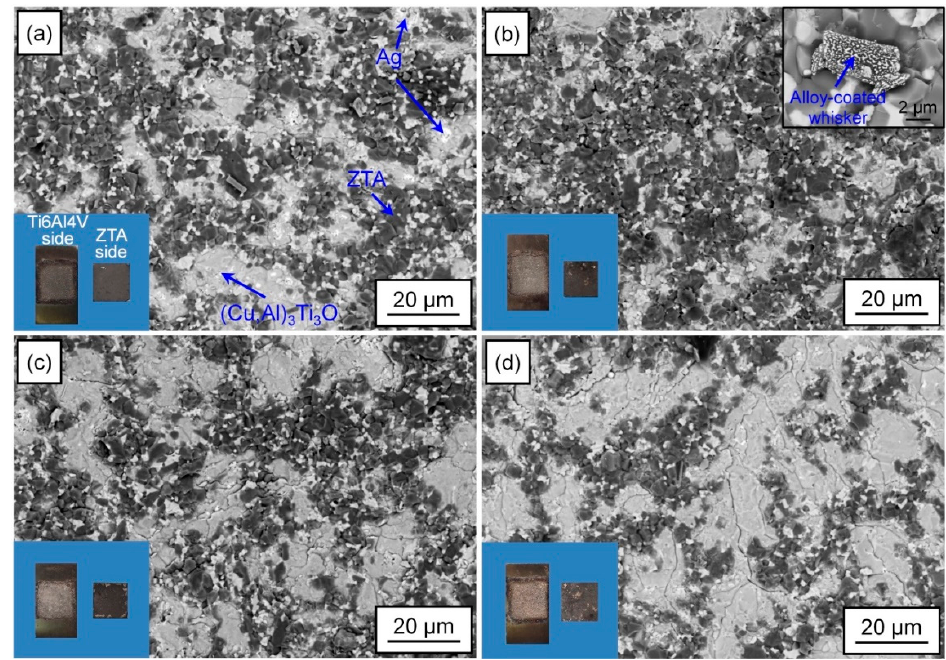
Figure 7. SE SEM and digital images of the fracture morphologies of the ZTA/AgCu + ABOw/Ti6Al4V joints brazed at ( a ) 800 ◦ C, ( b ) 825 ◦ C, ( c ) 850 ◦ C, and ( d ) 875 ◦